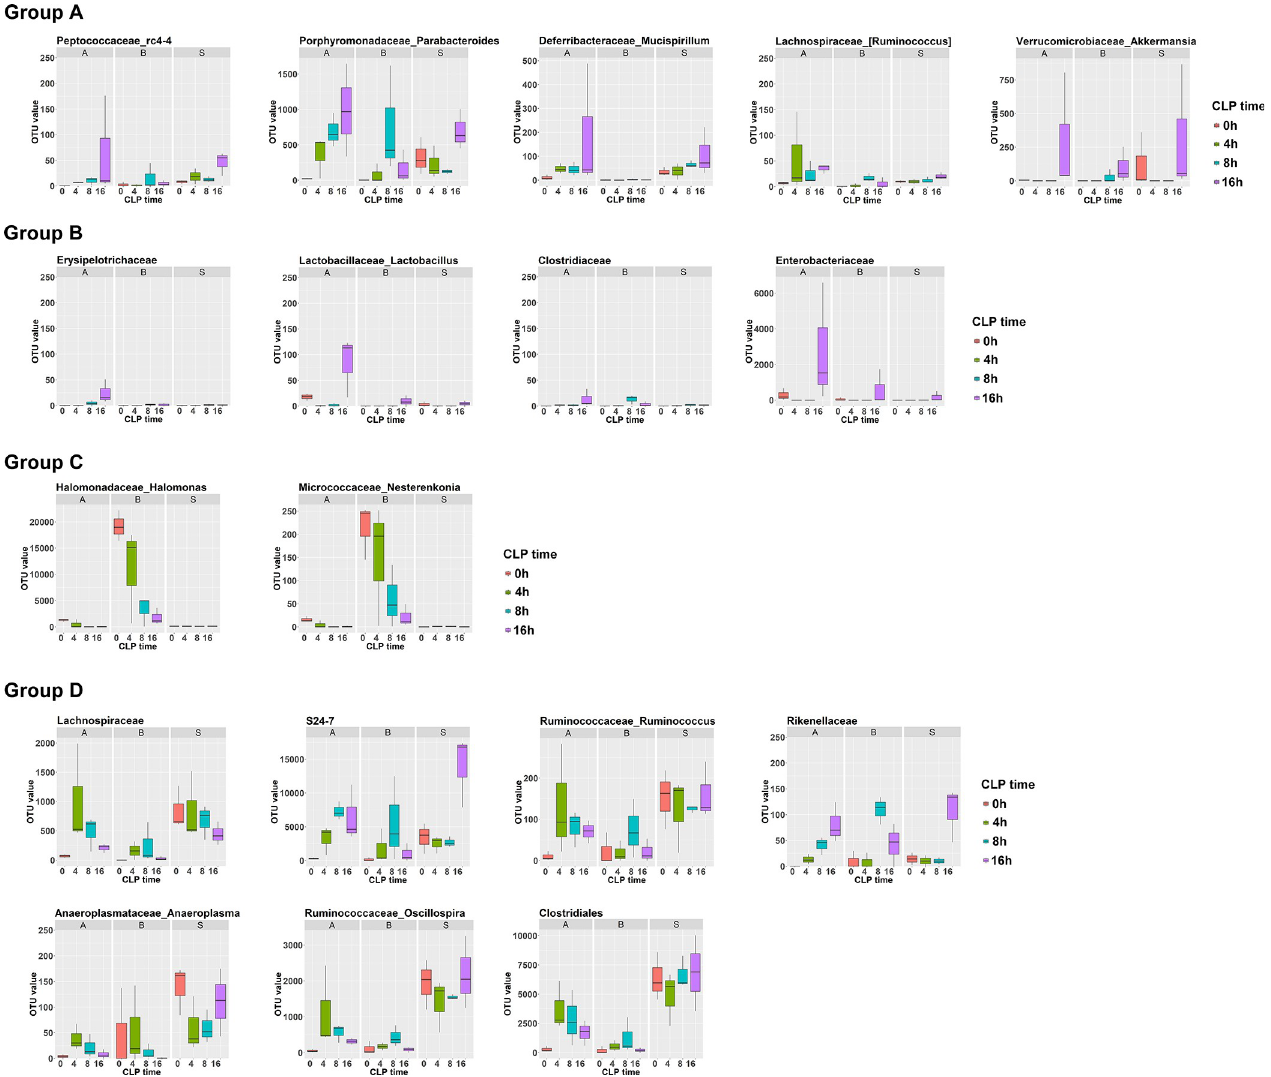
Fig 3. These bacteria can be divided into four groups according to their pattern of abundance across different samples at 16 h after cecum ligation and puncture (CLP) in C57BL/6 mice. Group A, the abundance of the bacterium between ascites and stool was similar but was much lower in the blood; Group B, the abundance of the bacterium in the ascites was much higher, regardless of a much lower abundance in the blood and stool; Group C, the abundance of the bacterium was much higher in the blood, but not in the ascites or stool; Group D, the abundance of the bacterium in the stool was high, but was lower in the ascites and blood. � indicated a significant different OUT number than those in the